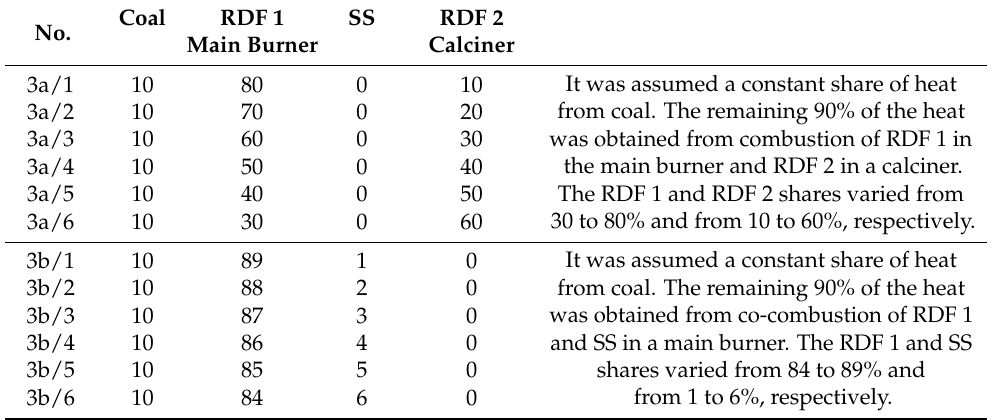
Table 1. The heat distribution in the two-components blends, (in %).